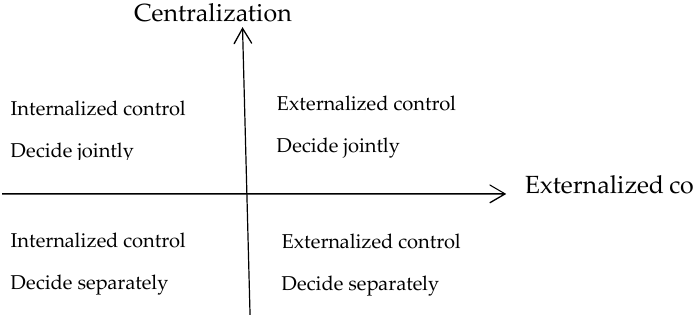
Figure 1. Analytical dimensions of governance structure.